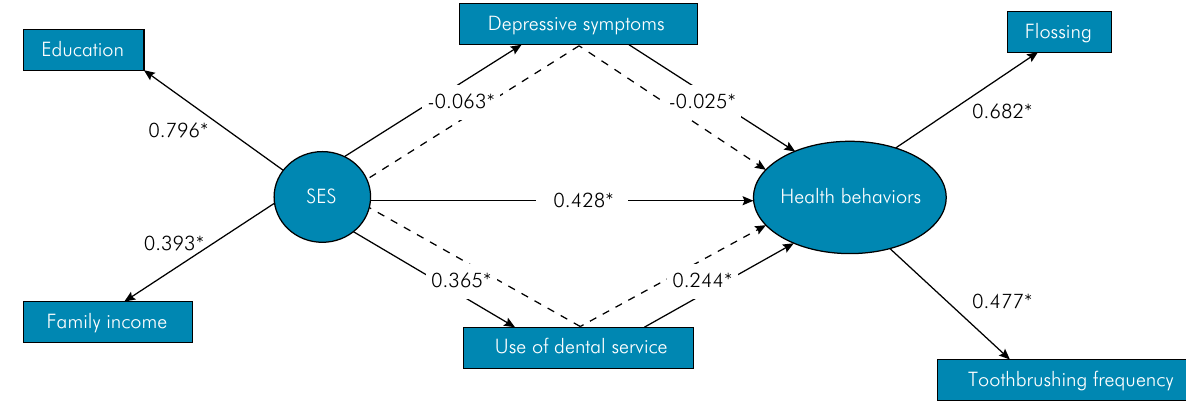
Figure. Path diagram of the model for health behaviors with standardized parameters.